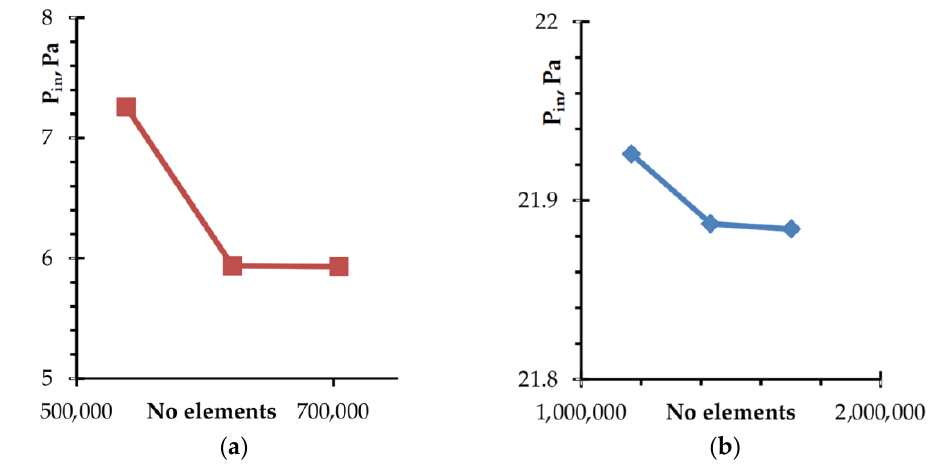
Figure 12. Mesh convergence for simplified ( a ) and real ( b ) models.